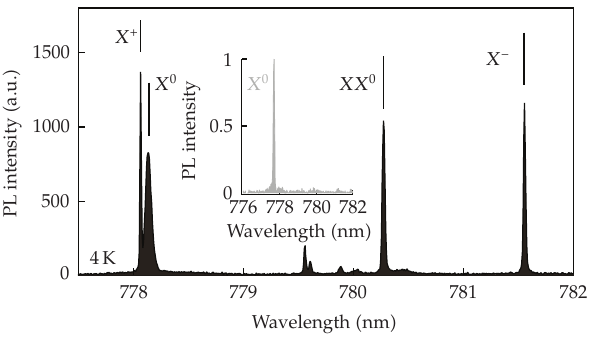
Figure 2: PL spectrum measured by single QD spectroscopy at 4K. Neutral exciton (cid:5) X 0 (cid:6) , neutral biexciton (cid:5) XX 0 (cid:6) , positively charged exciton (cid:5) X (cid:9) (cid:6) , and negatively charged exciton (cid:5) X − (cid:6) dominate the spectrum. (cid:5) Inset (cid:6) PL spectrum under X 0 selective population with weak barrier layer excitation.